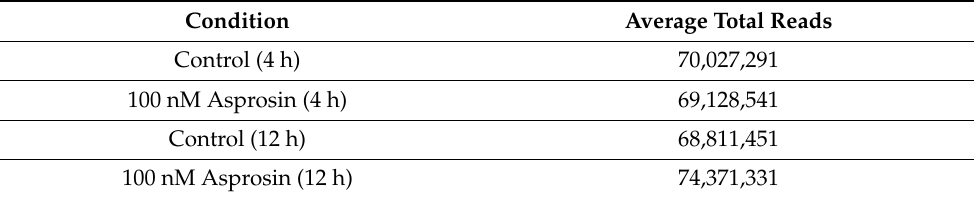
Table 2. Total number of reads. For paired-end sequencing values refer to the average sum of read 1 and read 2 in